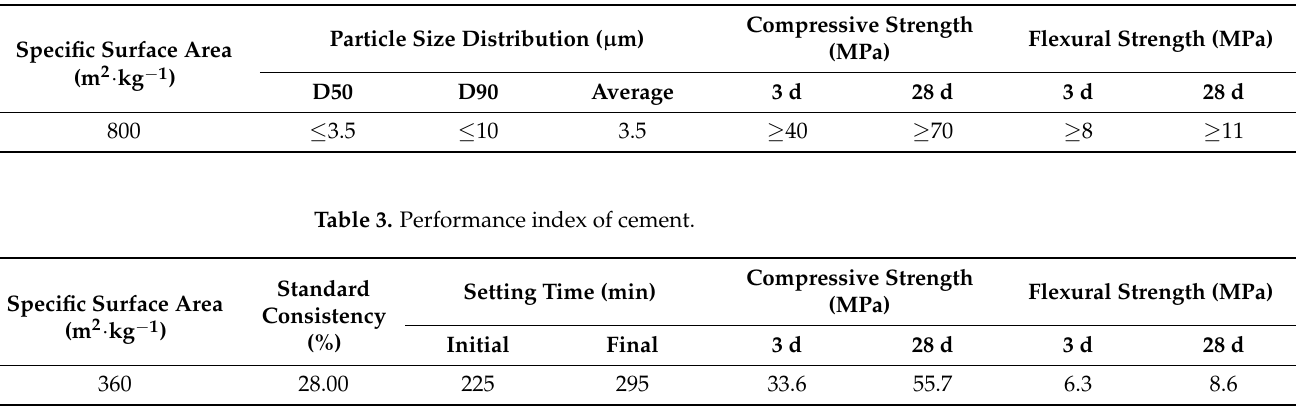
Table 2. Performance index of superfine cement.